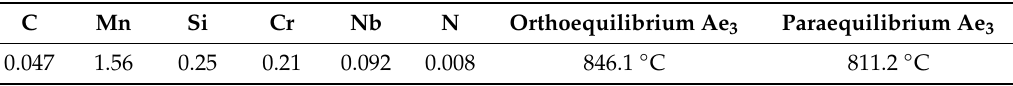
Table 1. Chemical composition (mass%) and equilibrium transformation temperatures ( ◦ C).